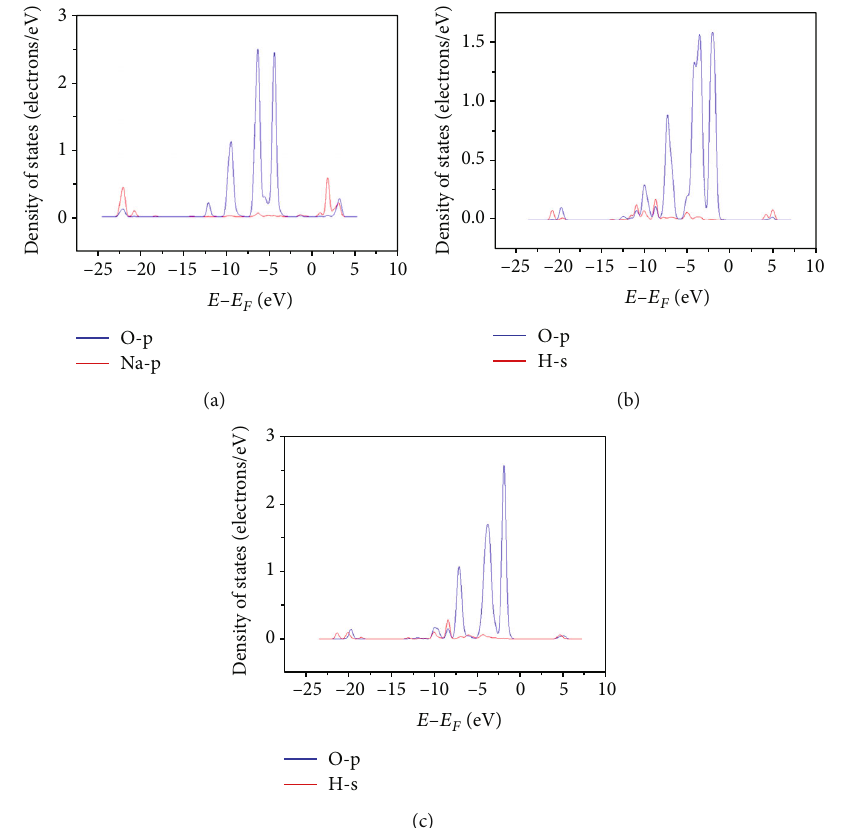
Figure 9: Density of states of sodium of (a) DTPA-5Na, hydrogen of (b) EDTMPS and (c) DTPMP is compared with oxygen atom of BaSO 4